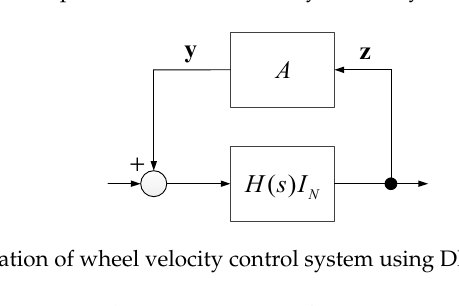
Figure 9. Expression of wheel velocity control system using DM-2.